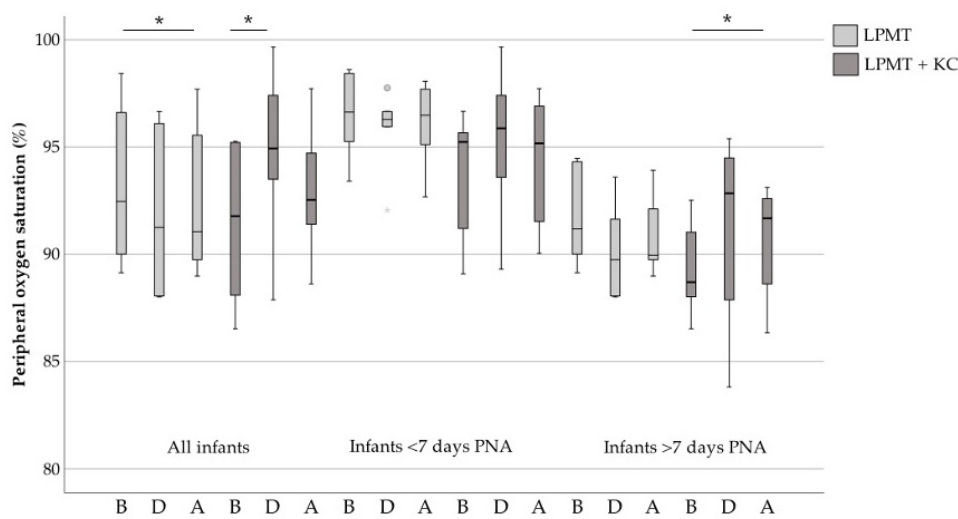
Figure 3. Oxygen saturation before, during and after LPMT compared with combined interventions. The boxes represent the interquartile ranges and the whiskers represent the range of all ages. Grey points and stars indicate the outliers of this study. LPMT: live-performed music therapy KC: kangaroo care; B, before therapy; D, during therapy; A, after therapy; *, p <